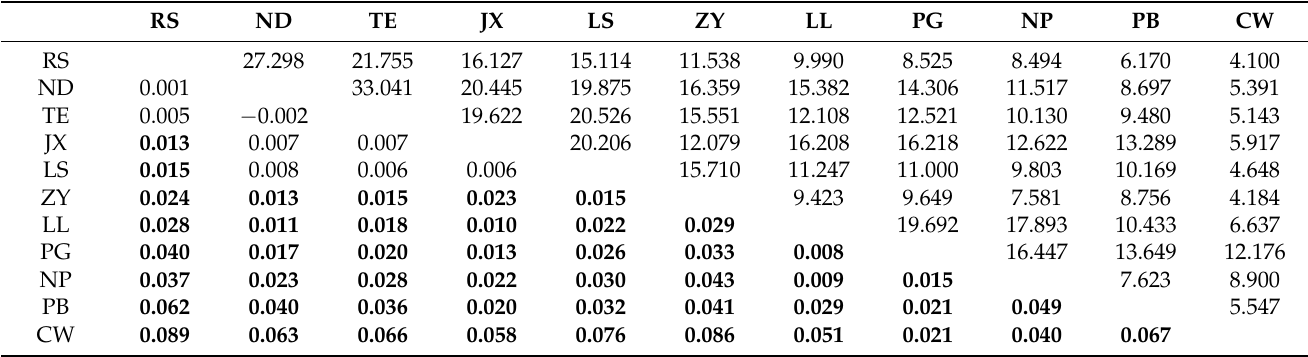
Table 6. Pairwise population differentiation based on F ST values and gene flow among Chinese fir in 11 sampling localities. Abbreviations for sampling localities are given in Table 1. Pairwise F ST below diagonal; Pairwise Nm above diagonal. Statistically significant results of allele size permutation tests to assess differences in F ST ( p < 0.05) are shown in bold type.